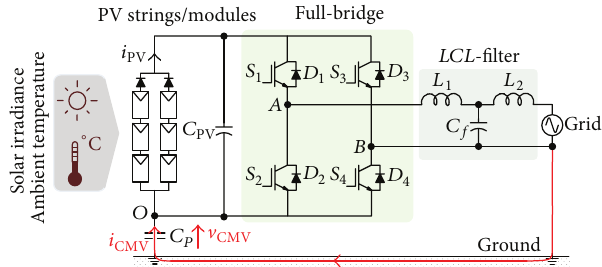
Figure 1: A single-phase single-stage grid-connected full-bridge PV inverter system with an LCL -filter, where V voltage and 𝐶 𝑃 is the stray